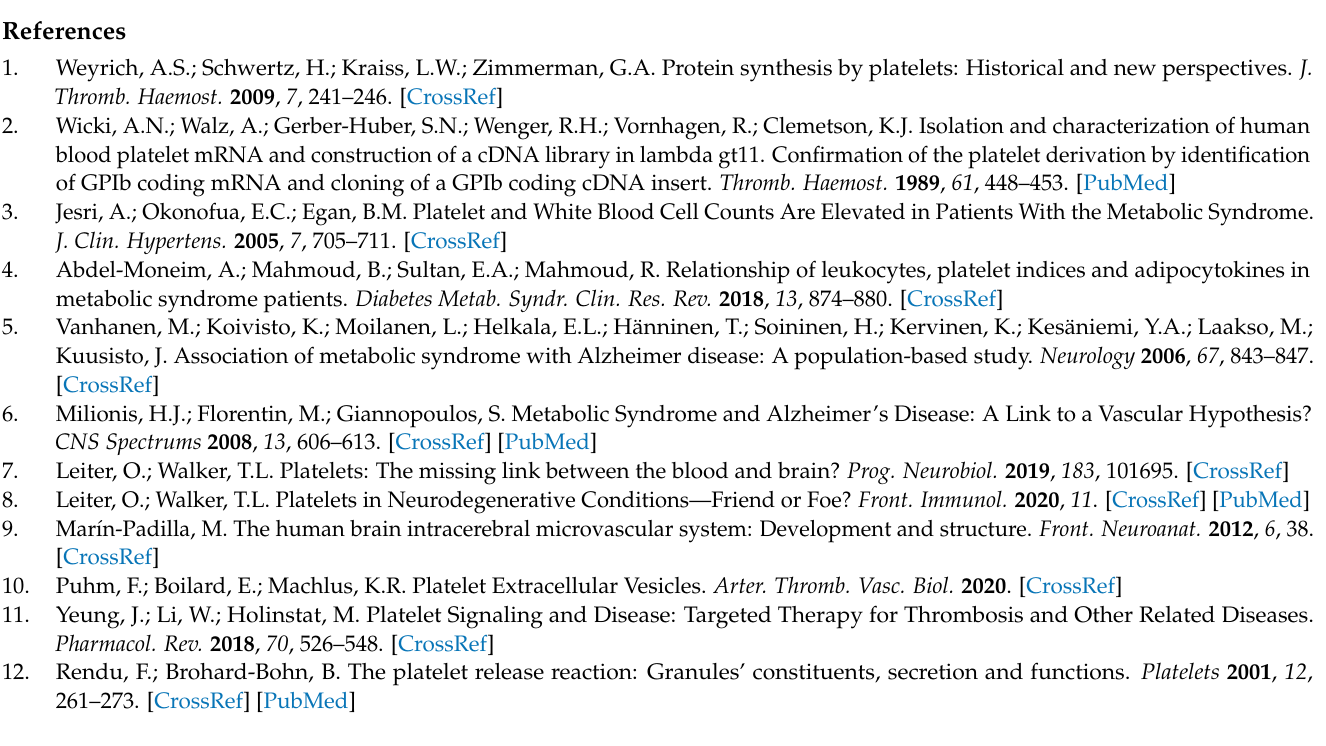
Figure 4. Graphical summary of dietary bioactive compounds on platelet function and neurovascular processes in MetS. This review underlines that activated platelets can have a significant contribution in neurovascular deterioration, and that specific endogenous and nutritional compounds can modulate these processes by attenuating platelet activation. It also restresses that a balanced diet is of importance to prevent or treat metabolic and neurological pathologies, and that it is plausible that the smallest anucleate cells of the body play roles in this pro- cess.